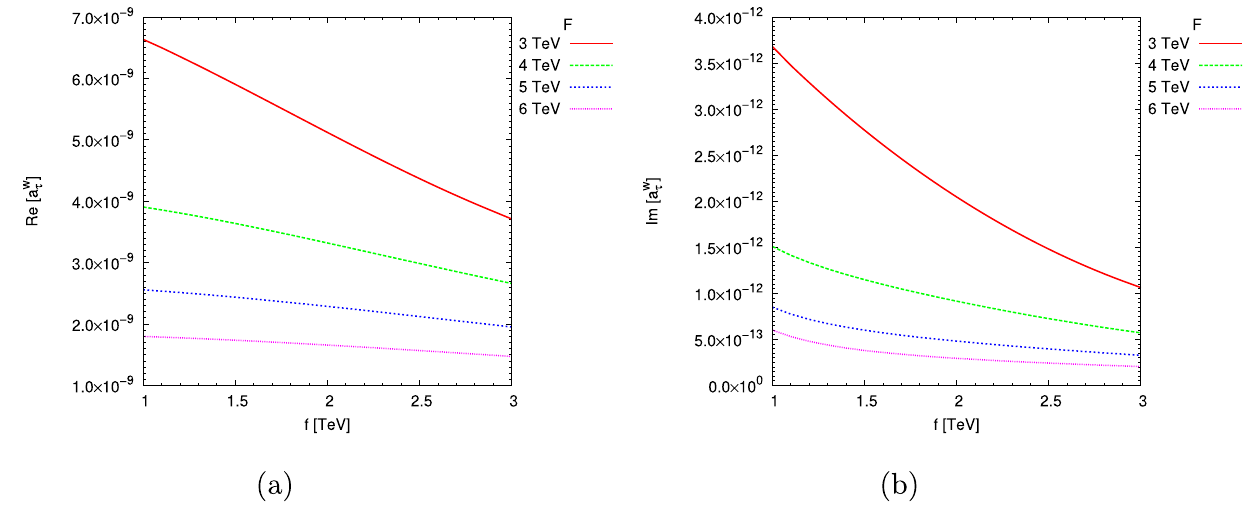
Fig. 11 Total contribution to a W τ for different values of the energy scale F . a Re( a W τ ). b Im( a W τ ). The plots are obtained for certain fixed values of the F scale. The values provided in Table 3 are used for the remaining parameters of the model